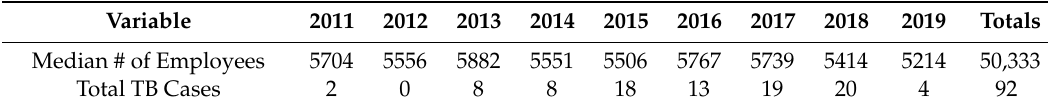
Table 1. Distribution of Cases and Employees.